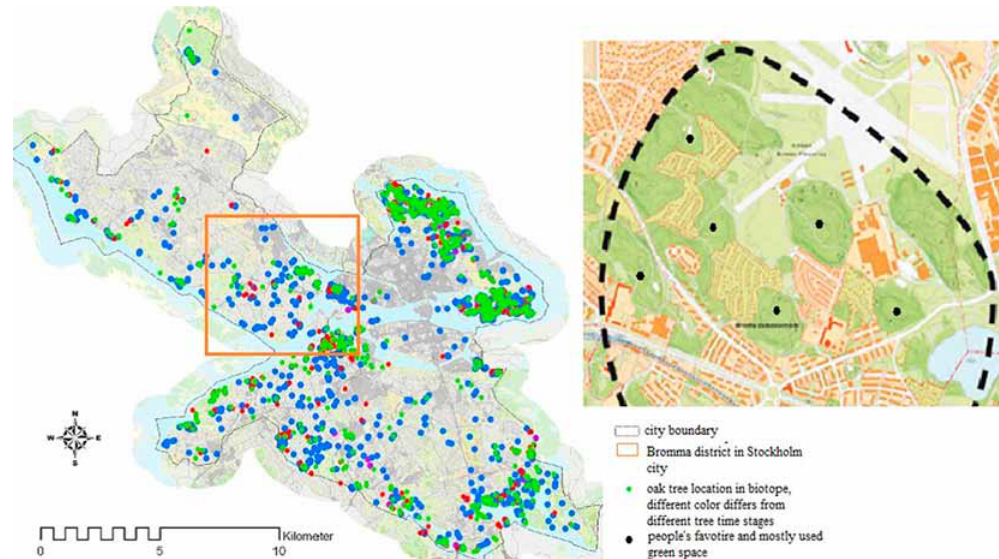
fig. 9. Biotope (left) and sociotope (right) map of Bromma, Stockholm. Biotope mapping in Stockholm uses oak trees as one of the important habitats that provide refuge, reproduction and connection areas for many fauna species. a sociotope map is based on people’s perception of green spaces. The dark green color represents the favorite and most frequently used places by residents (Stockholm